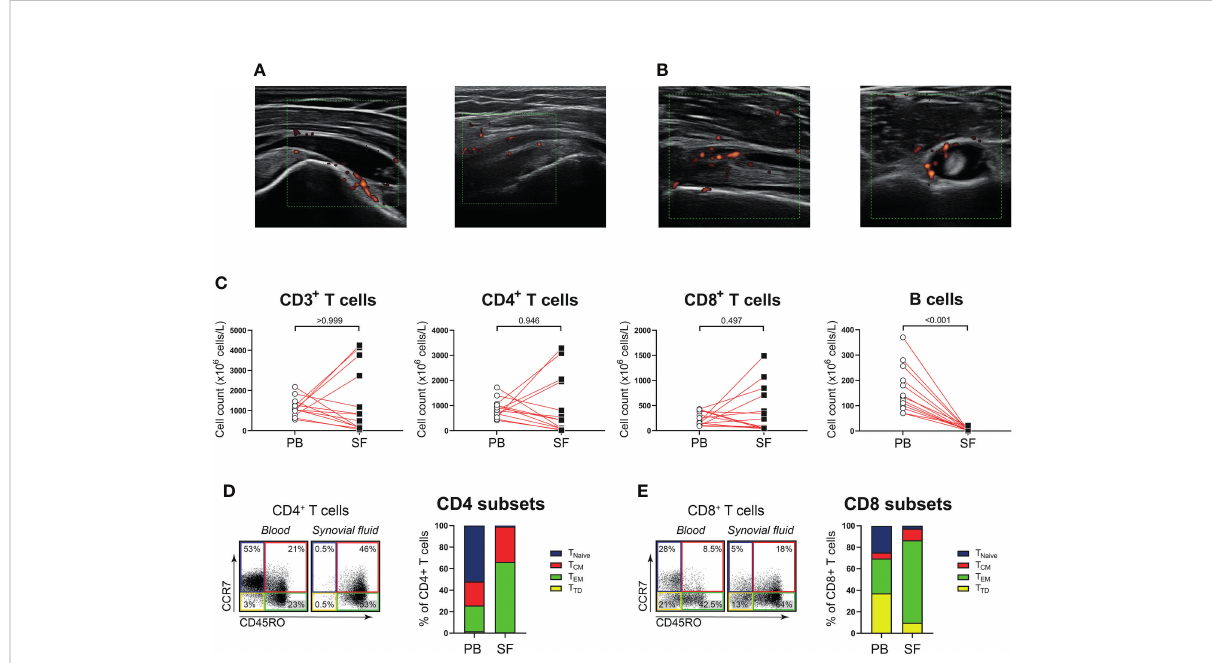
FIGURE 3 T cells in synovial fl uid compartment of patients with PMR. (A) Representative ultrasound images of the in fl amed subacromial-subdeltoid bursa of two patients with PMR. (B) Representative ultrasound images of the in fl amed biceps tendon sheath of a patient with PMR, with the biceps tendon in longitudinal view (left panel) and transverse view (right panel). (C) Absolute numbers of CD3 + T cells, CD4 + T cells, CD8 + T cells and CD19 + B cells in peripheral blood (PB) and synovial fl uid (SF) of 13 patients with PMR. (D) Representative fl ow cytometric staining (left panel) and percentages (right panel) of CD45RO - CCR7 + naive (T Naive ), CD45RO + CCR7 + central memory (T CM ), CD45RO + CCR7 - effector memory (T EM ) and CD45RO - CCR7 - terminally differentiated (T TD ) CD4 + T cells and (E) CD8 + T cells in PB and SF of 9 patients with PMR. Statistical signi fi cance by Wilcoxon signed rank test is